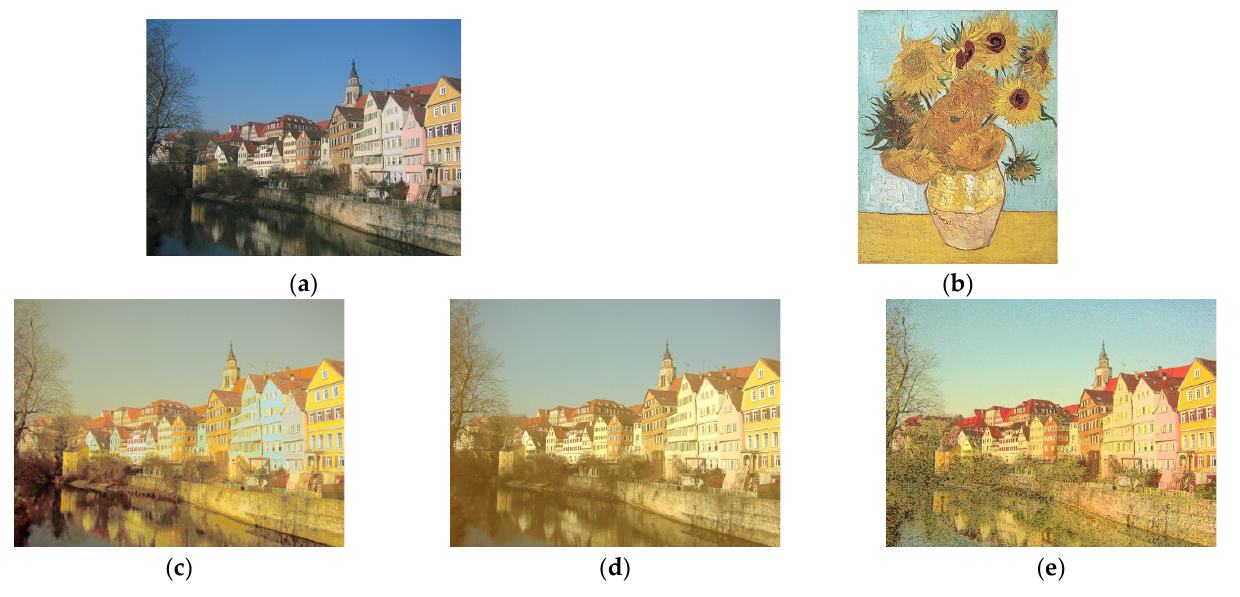
Figure 15. Comparison with Reinhard et al.’s method and Jimenez-Arredondo et al.’s method. ( a ) Content image. ( b ) Target image. ( c ) The result image of our color-transferred method. ( d ) The result of Reinhard et al.’s method. ( e ) The result of Jimenez-Arredondo et al.’s method.